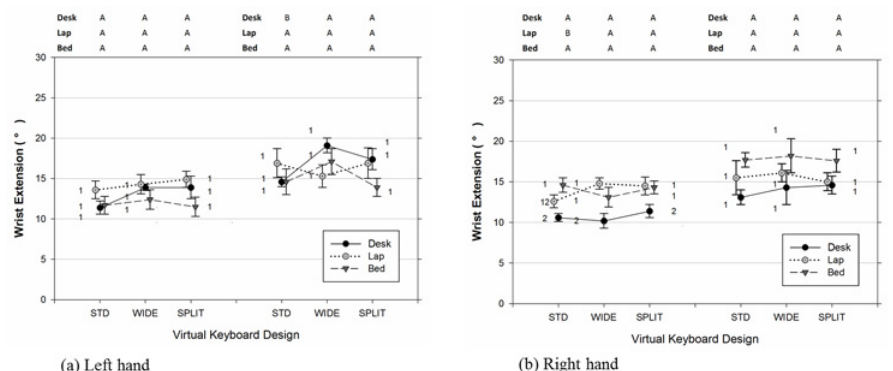
Fig 5. Range of wrist movement (APDF Range) in term of extension/flexion for the (a) left (non- dominant) and (b) right (dominant) hand varied across different positions of tablet usage and virtual keyboard designs. Error bars represent +/- 1 SE. The conditions observed from the early 10 – 25 min period (left side) and later 55 – 60 min period (right side) are separated accordingly in each sub figure. Conditions with the same number (1, 2, 3) denote groups without significant difference across the usage positions within the same virtual keyboard design. Conditions with the same character (A, B, C) denote groups without significant difference across the keyboard designs within the same usage position.